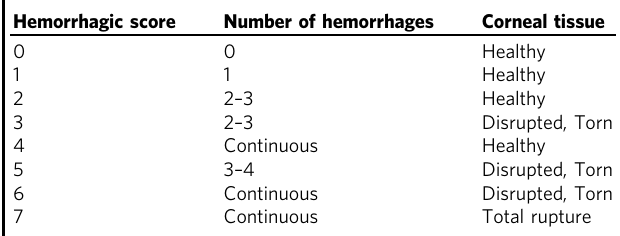
Table 1 Scale used to quantify extent of hemorrhaging and health of corneal tissue following burn. Scale is based on the number of hemorrhages surrounding the corneal circumference as well as the integrity of the corneal